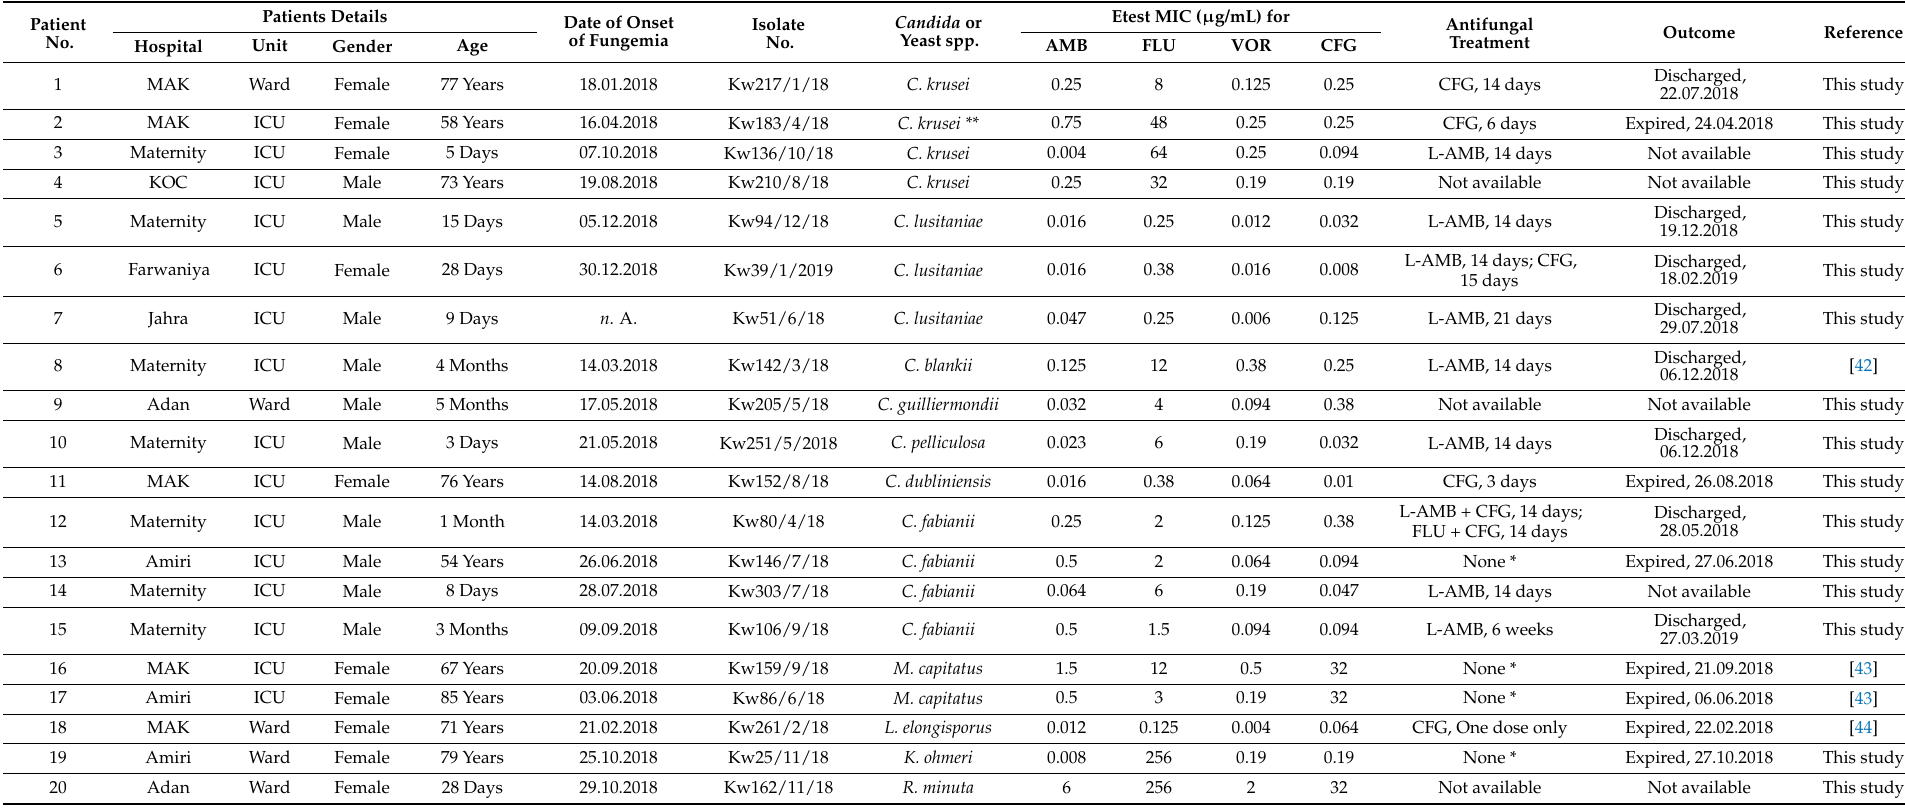
Table 7. Demographic and clinical details of patients infected with other Candida /yeast species, susceptibility data, treatment given, and outcome. Patient